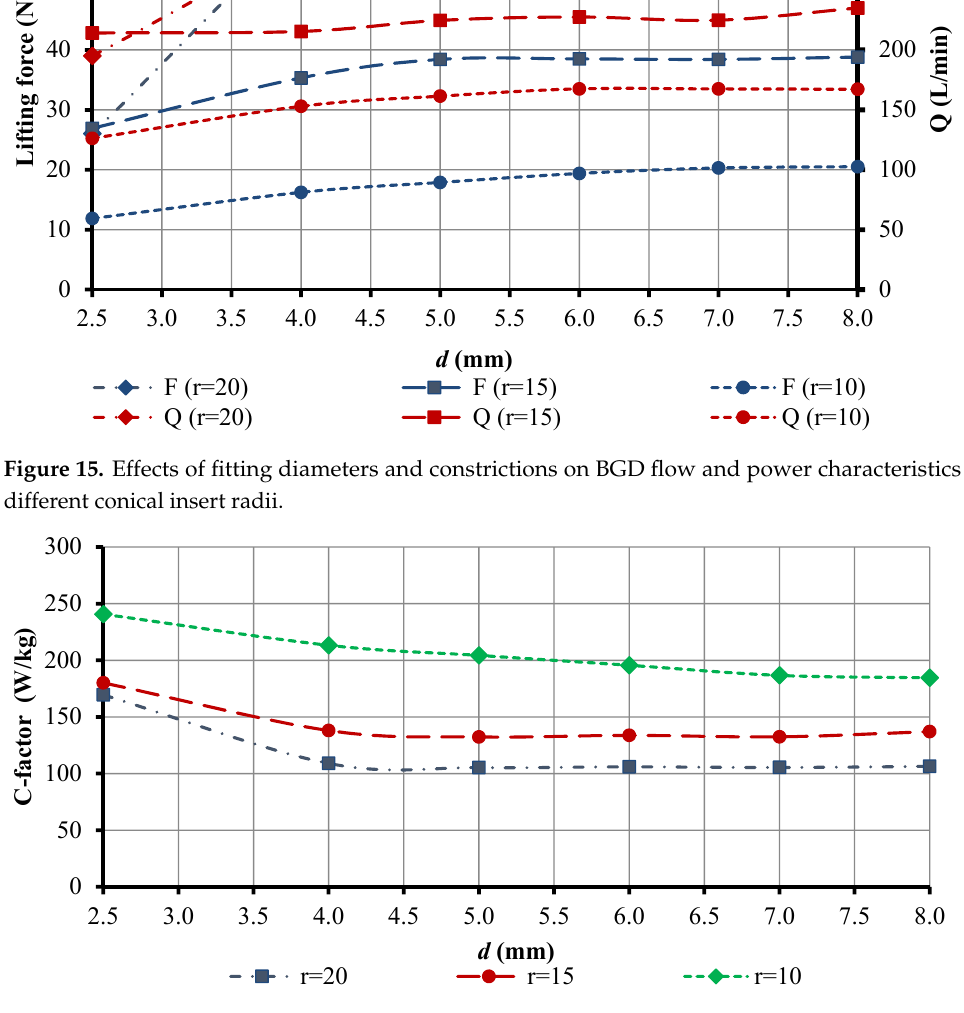
Figure 15. Effects of fitting diameters and constrictions on BGD flow and power characteristics at different conical insert radii.